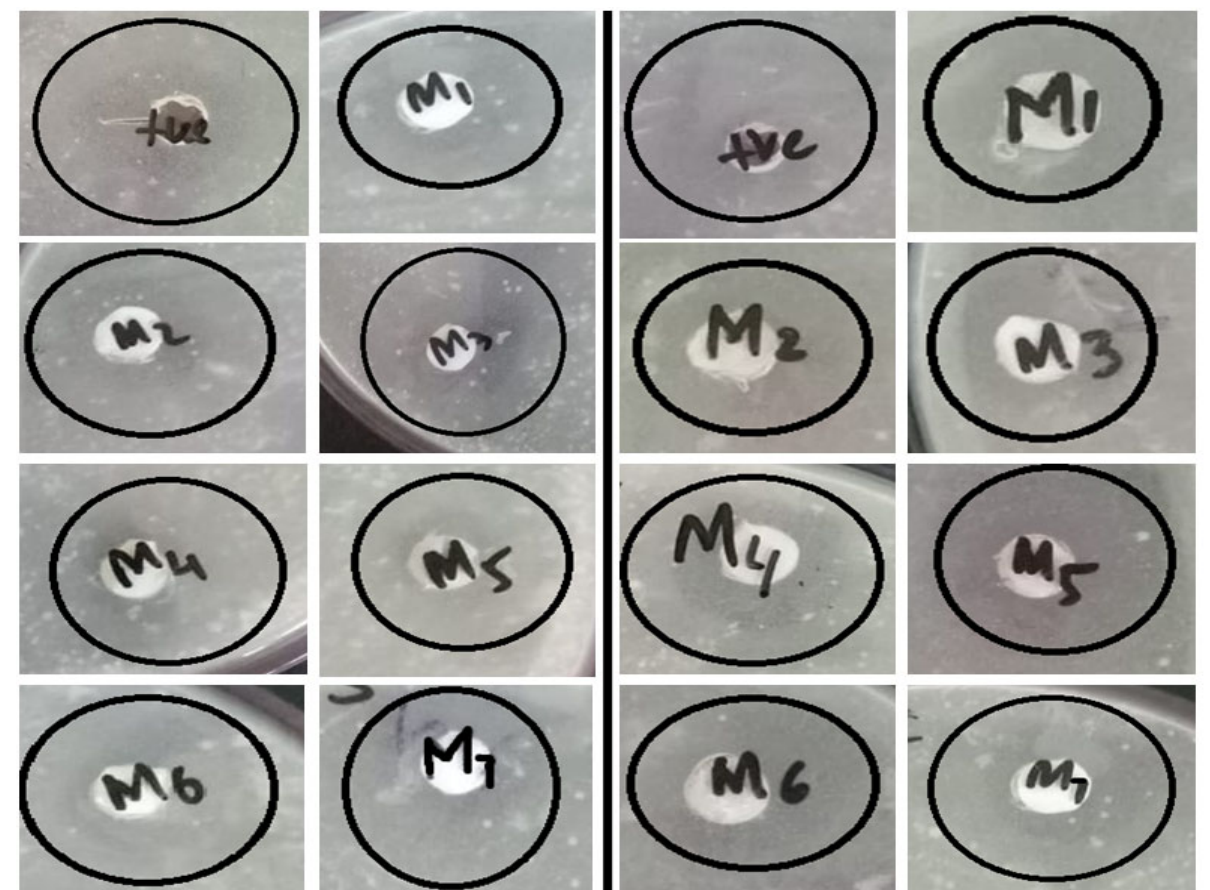
Figure 11. Anti ‐ bacterial activity of nanocomposite membranes.